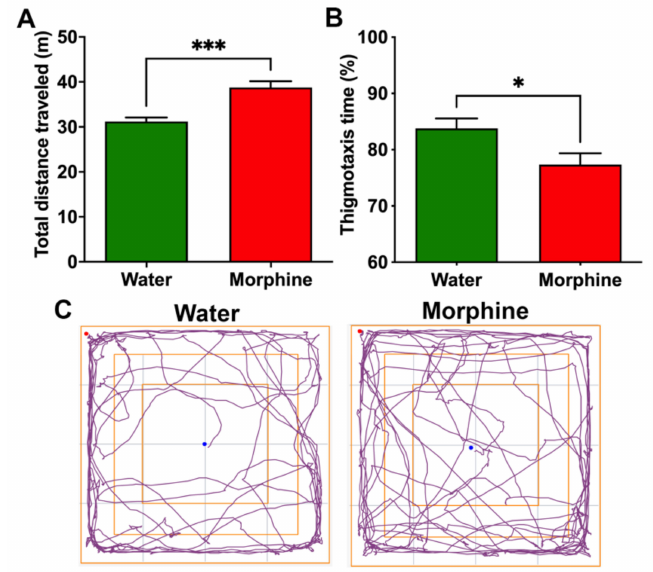
Figure 4. Voluntary morphine intake induces hyperlocomotor activity in Wistar rats. ( A ) Total distance traveled and ( B ) Thigmotaxis time (%) as a measure of time spent near the walls during the five minute session of the open field test of rats that had voluntarily consumed morphine for four weeks. Animals drinking only water were used as controls. ( C ) Trajectory plot of rats drinking morphine and water showing entries to the center of the open field. The open field test was conducted during the first hour of light. Data are expressed as means ± SEM. n = 8 in each experimental group. * p < 0.05; *** p < 0.001, two-tailed Student t